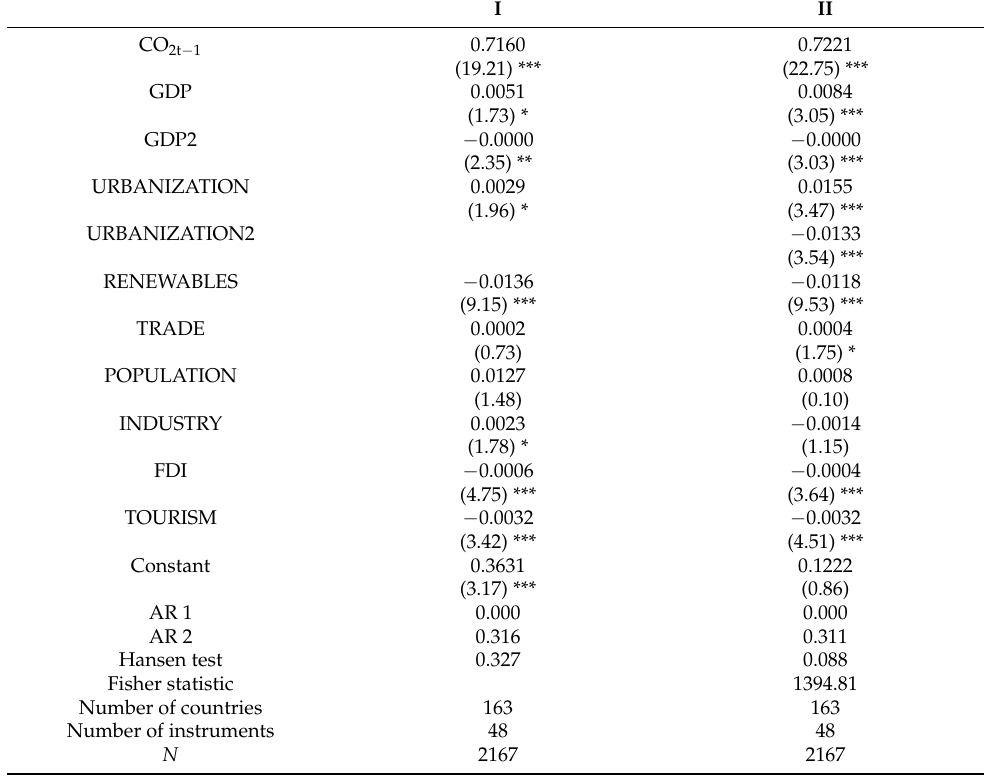
Table 3. Main results: Two-step GMM